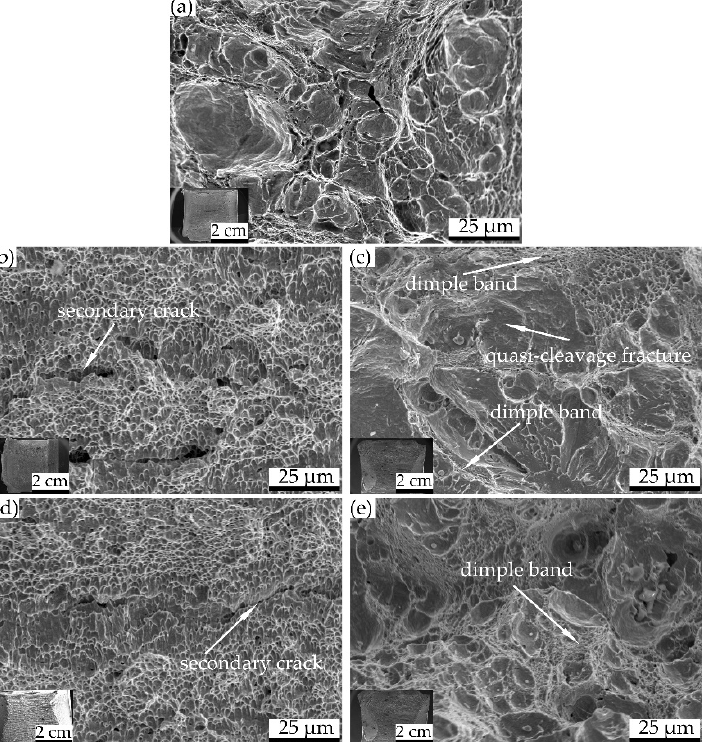
Figure 11. Impact fracture morphology. ( a ) Original casting; ( b ) once repair welding WM; ( c ) once repair welding HAZ; ( d ) twice repair welding WM; ( e ) twice repair welding HAZ.